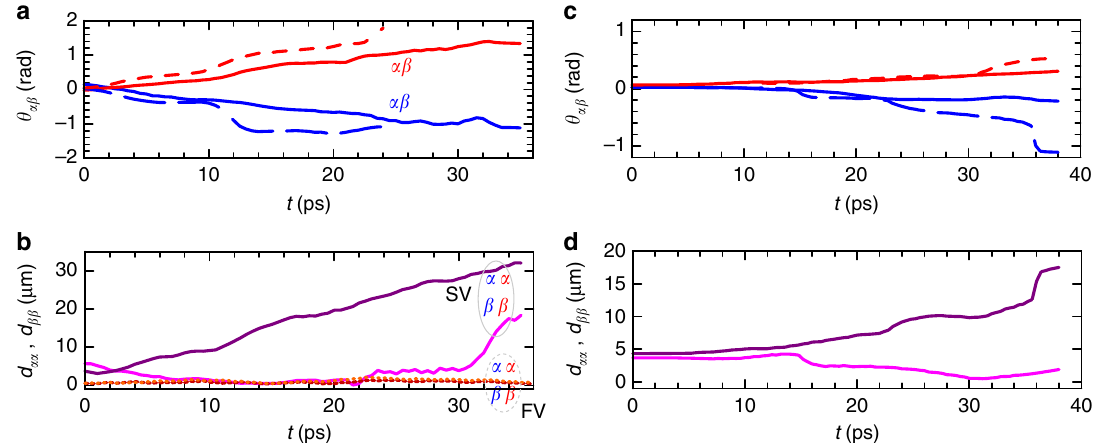
Fig. 5 Rotational split of composite spin vortices. a Evolution of the intervortex angle θ αβ in the spin – vortex case for the full timespan, showing the differing rotation directions for the σ + (solid blue) and σ − (solid red) spin components as shown in Fig. 4c, d, f. A double power case is reported too (dashed blue and red lines). b Inter-spin distances d αα and d ββ between the initially close, opposite-spin cores for both the spin vortices (SV, purple and magenta solid lines) and full vortices (FV, orange and red dashed lines). c Numerical intra-spin, intervortex angle θ αβ and d the inter-spin distances d αα and d ββ for the counterwinding spin – vortex case, corresponding to the experimental panels a , b , respectively. The α and β labels indicate the spatially separated, cowinding, vortex cores inside each of the two spin populations, as in Fig. 4a, e, c,